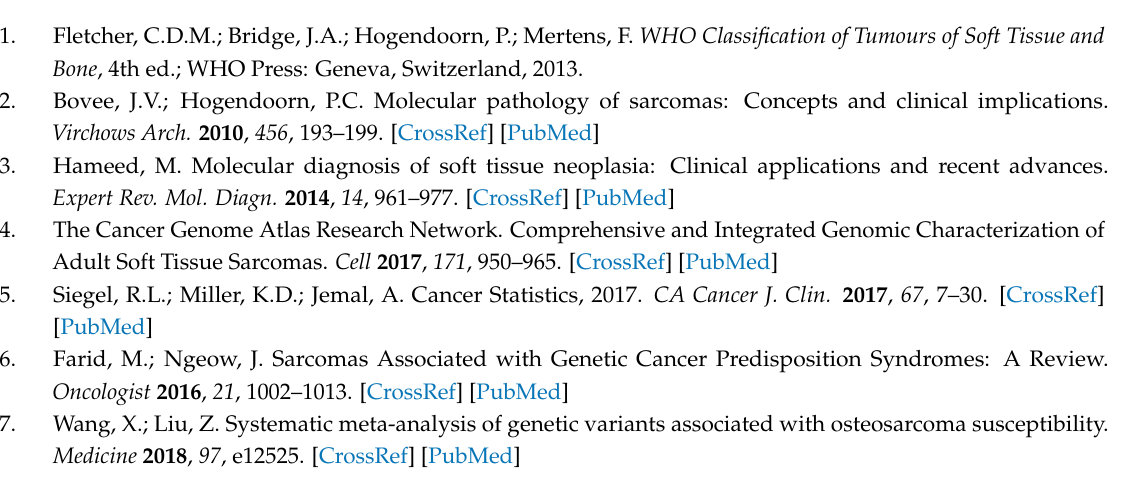
Supplementary Table S1: Summary of reported cell lines and the relevant information; Supplementary Table S2: A list of histological subtypes that did not have corresponding cell